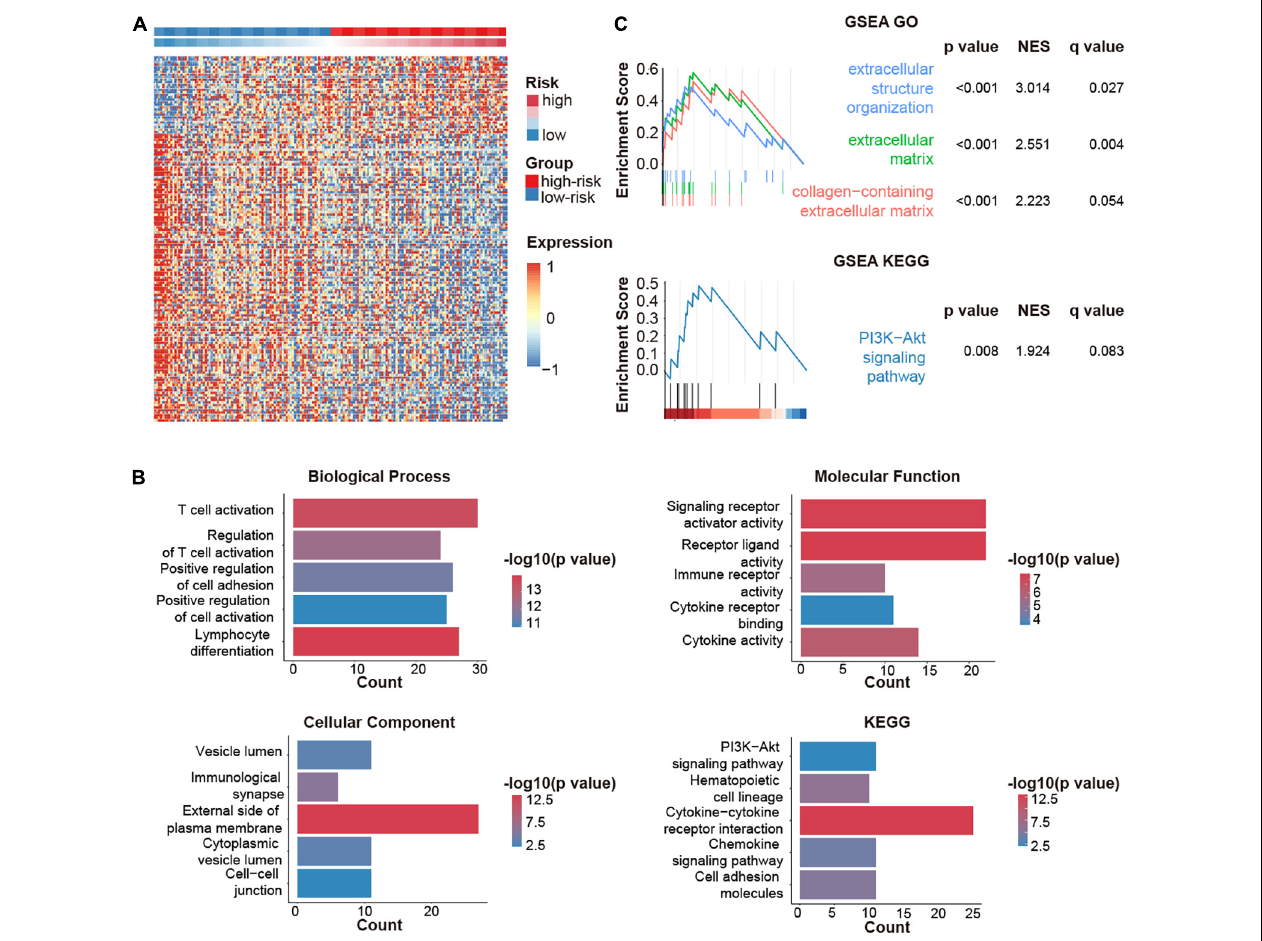
FIGURE 5 | CMGs-based signature (CMS)-related biological pathways. (A) DEGs in different risk groups. (B) GO and KEGG analyses based on DEGs. (C) DEGs were analyzed by GSEA. NES: normalized enrichment score.